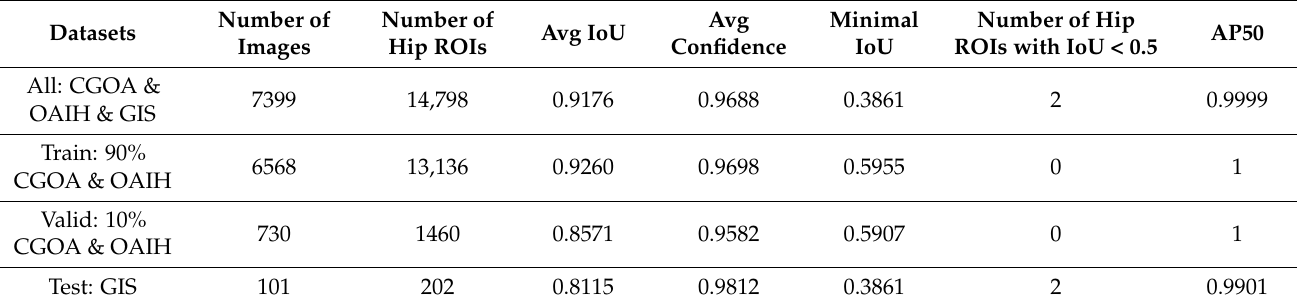
Table 2. Detailed performance metrics with the optimal parameters using the proposed hip region detection architecture.